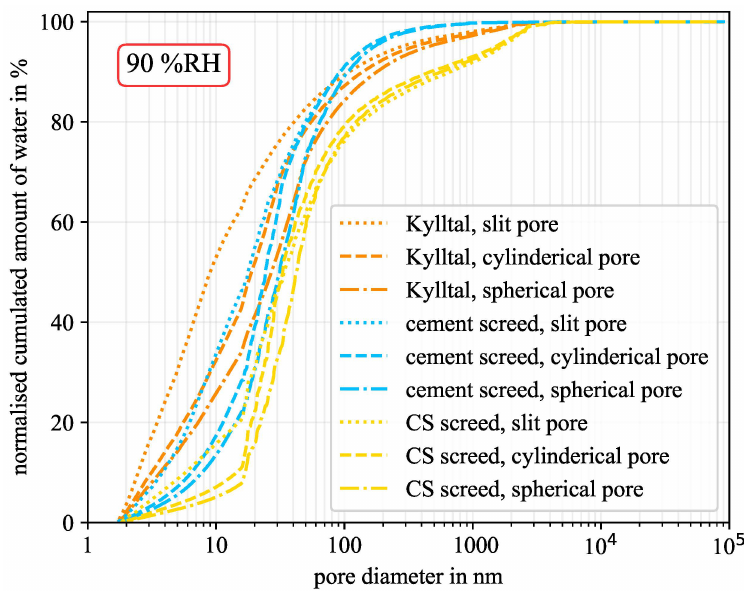
Figure 5. Normalised cumulated amount of water at 90% RH for the three pore geometries. (CS—calcium sulphate).